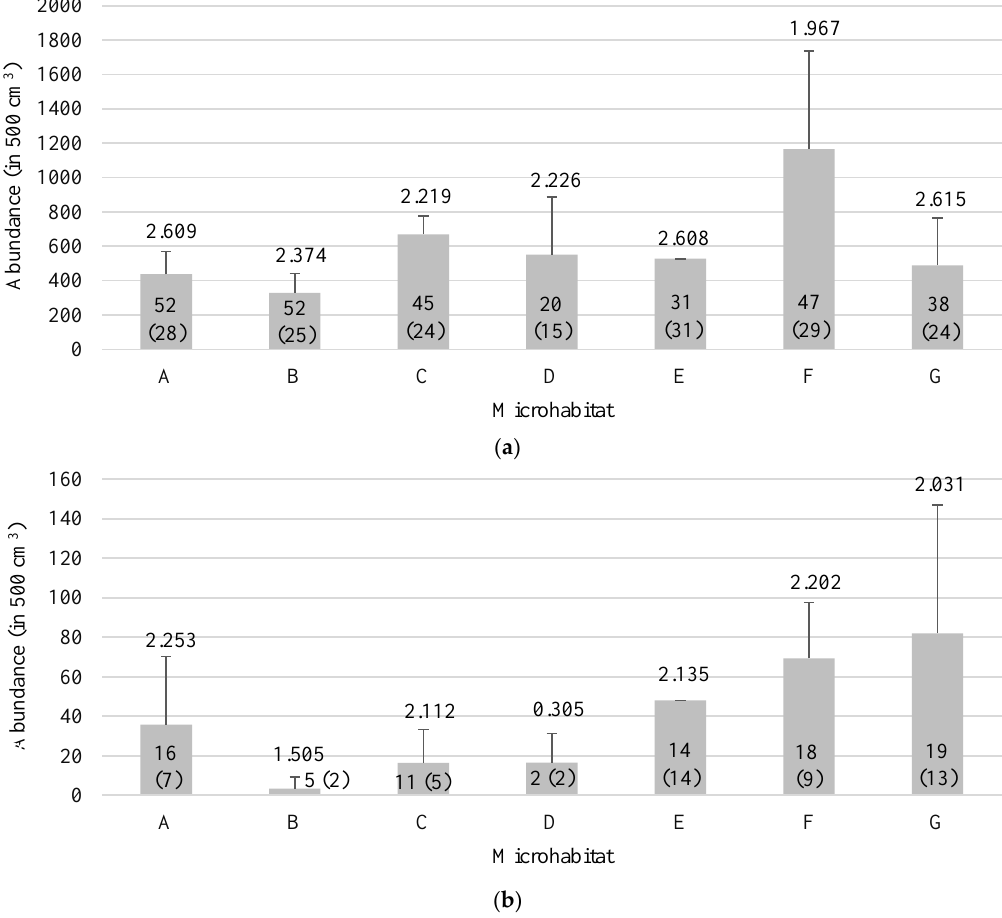
Figure 4. Average abundance (in 500 cm 3 ) of Oribatida ( a ) and Mesostigmata ( b ) (bars) with standard deviation (whiskers), Shannon index (above bars) and number of species (total and in brackets mean number per sample, in bars) in microhabitats of broadleaf forest in Eastern Norway: A — moss on ground, B — lichens on tree twigs lying on ground, C — moss on tree trunks at ground level, D — moss on tree trunks 1.5 m above ground, E — moss on decaying stump, F — moss on decaying log, G — decaying wood from trees.